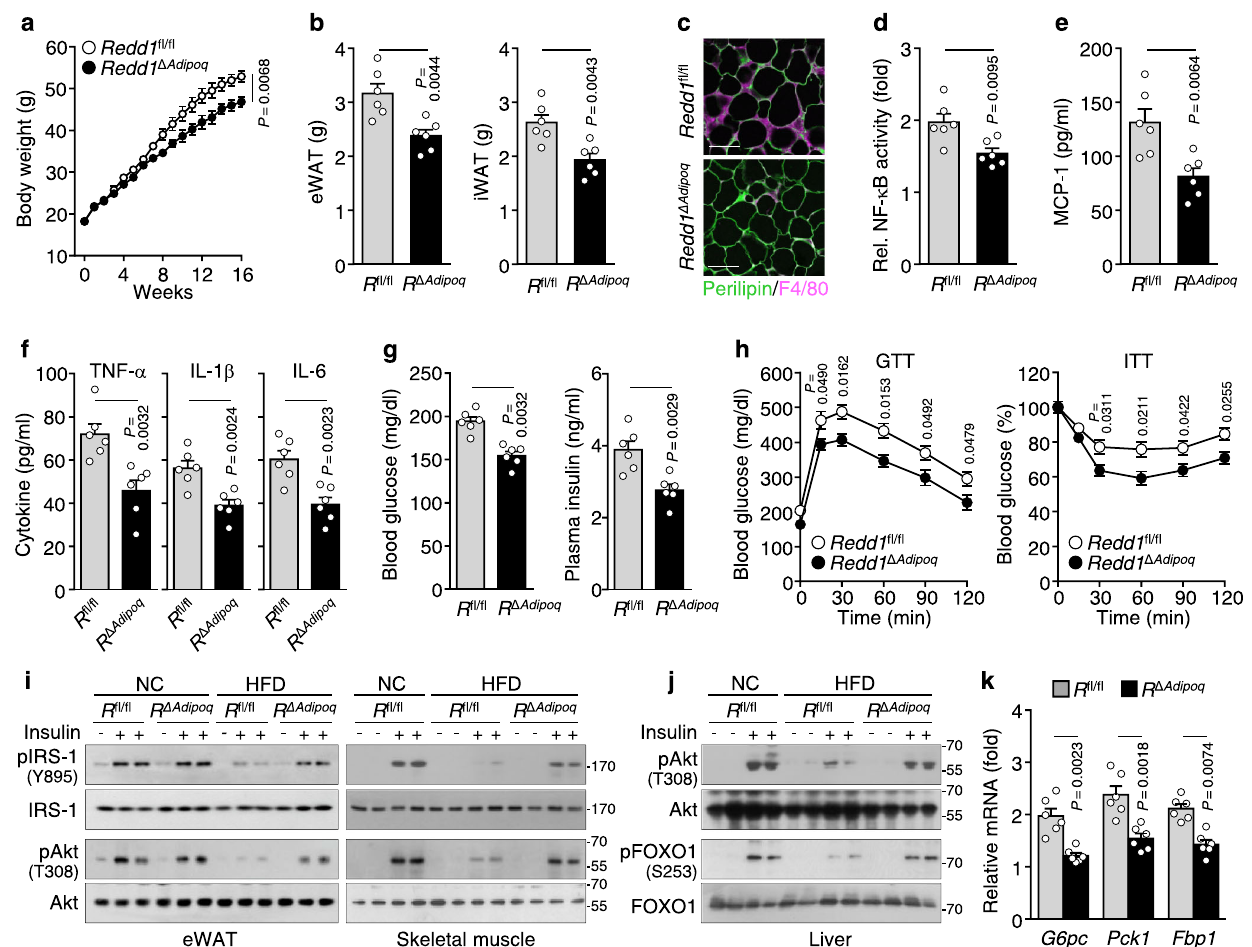
Fig. 3 | Adipocyte Redd1 deletion prevents HFD-induced obesity and in fl am- mation. a Weight gainover time in Redd1 fl / fl ( R fl / fl )and Redd1 Δ Adipoq ( R Δ Adipoq ) mice fed HFD for16 weeks ( n =6 per group). b Mass measurements for the eWATand iWAT inHFD-fed Redd1 fl / fl and Redd1 Δ Adipoq mice( n =6pergroup). c Representativeimages showing perilipin (green) and F4/80 (purple) staining in the eWAT of Redd1 fl / fl and Redd1 Δ Adipoq mice fed HFD ( n =6 per group). Scale bar, 100 μ m. d NF- κ B activity in theeWATfromHFD-fed Redd1 fl / fl and Redd1 Δ Adipoq mice( n =6pergroup). e , f Plasma levelsofin fl ammatorycytokinesinHFD-fed Redd1 fl / fl and Redd1 Δ Adipoq mice( n =6per group). g Fasting plasma levels of glucose and insulin in HFD-fed Redd1 fl / fl and